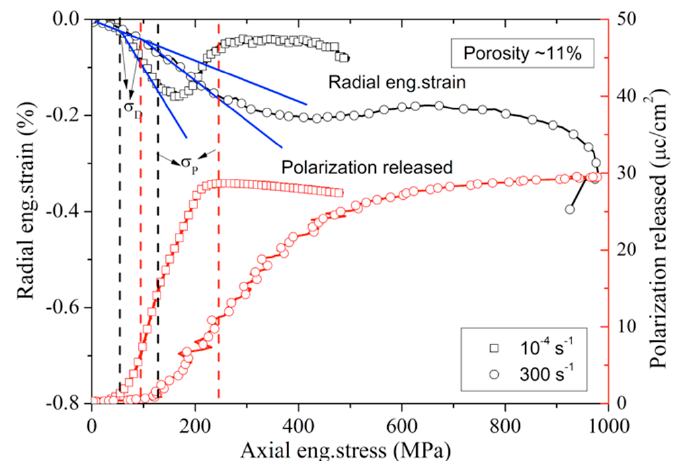
Figure 16. Eng.stress vs. radial eng.strain and eng.stress vs. polarization released curves of porous poled PZT95/5 ceramics at different strain rates.